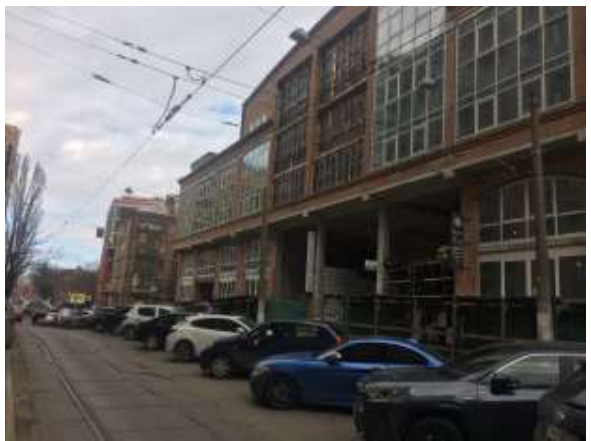
Figure 1 . The office building on Dmitrievskaya street in